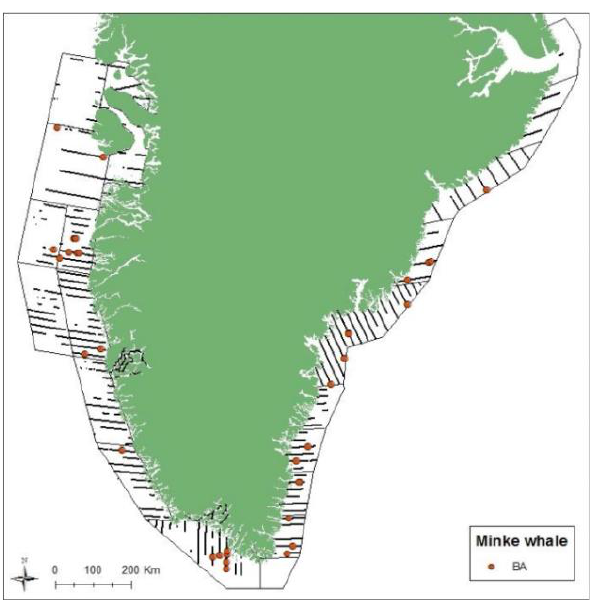
Figure 2. Sightings and survey effort in sea states <3 for minke whales in East and West Greenland.